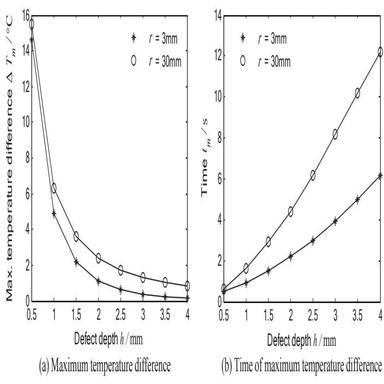
Defect informative parameters vs. defect depth (H = 10 mm).